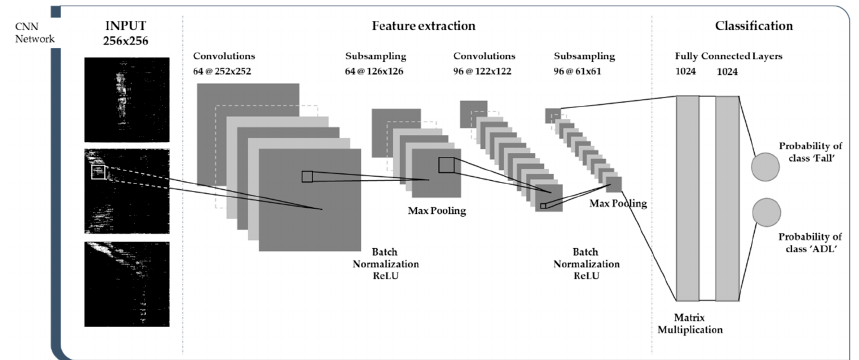
Figure 8. Architecture of convolution neural network (CNN) implemented for fall detection with classification of IR-UWB visualization image. classification of IR-UWB visualization